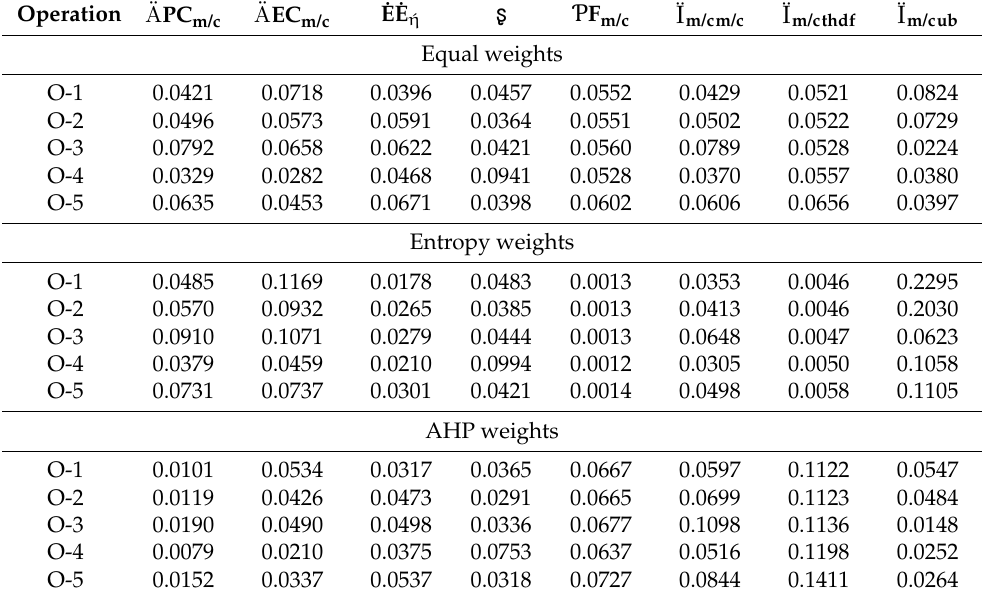
Table A4. Weighted normalized matrix ( ˆW ˙Z ij ) TOPSIS.